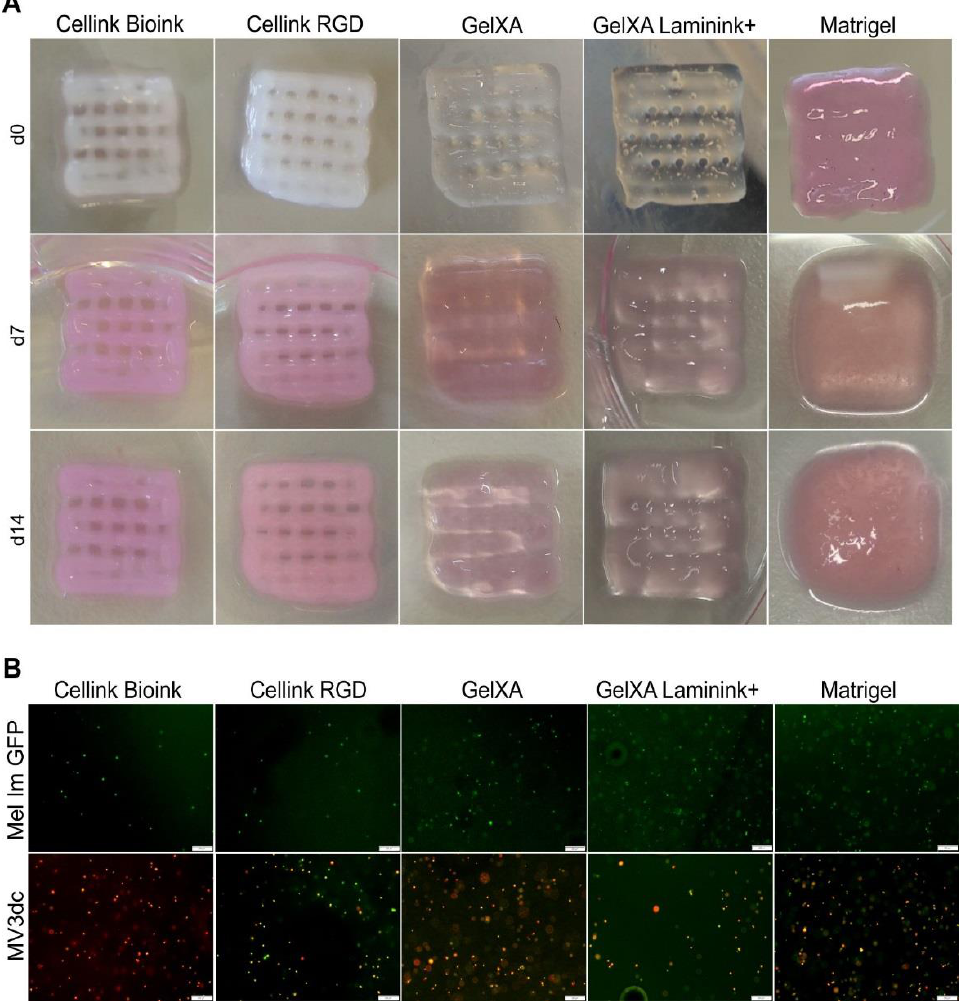
Figure 1. Printability of bioink and cell distribution. Constructs with an area of 1 cm 2 , three layers high, containing 10 5 cells / mL were printed with Cellink Bioink, Cellink RGD, GelXA, GelXA Laminink + or Matrigel, respectively, using the Cellink+ bioprinter. ( A ) Representative macroscopic images of cell-loaded 3D printed constructs at time points d0, d7, and d14. ( B ) Representative fluorescence microscope images of melanoma cell lines Mel Im GFP (green) and MV3dc (red/green) in the respective inks 1 day after 3D printing. Scale bars represent 200 µm.